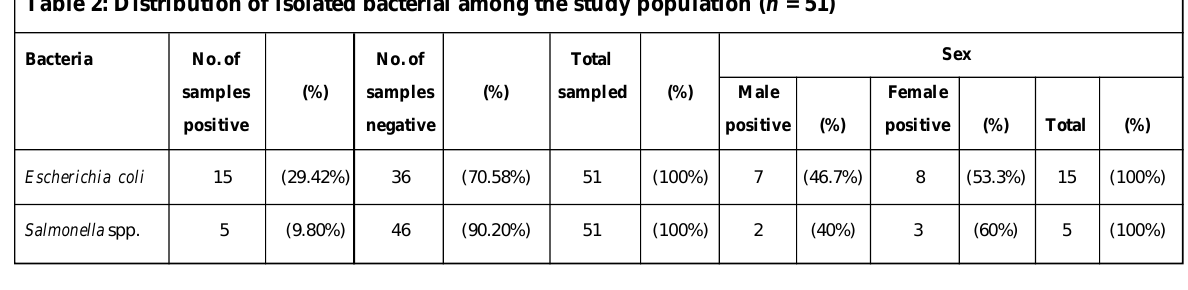
Table 3: Age and gender distribution of Escherichia coli and Salmonella spp. isolates. Escherichia coli Salmonella spp. Age group